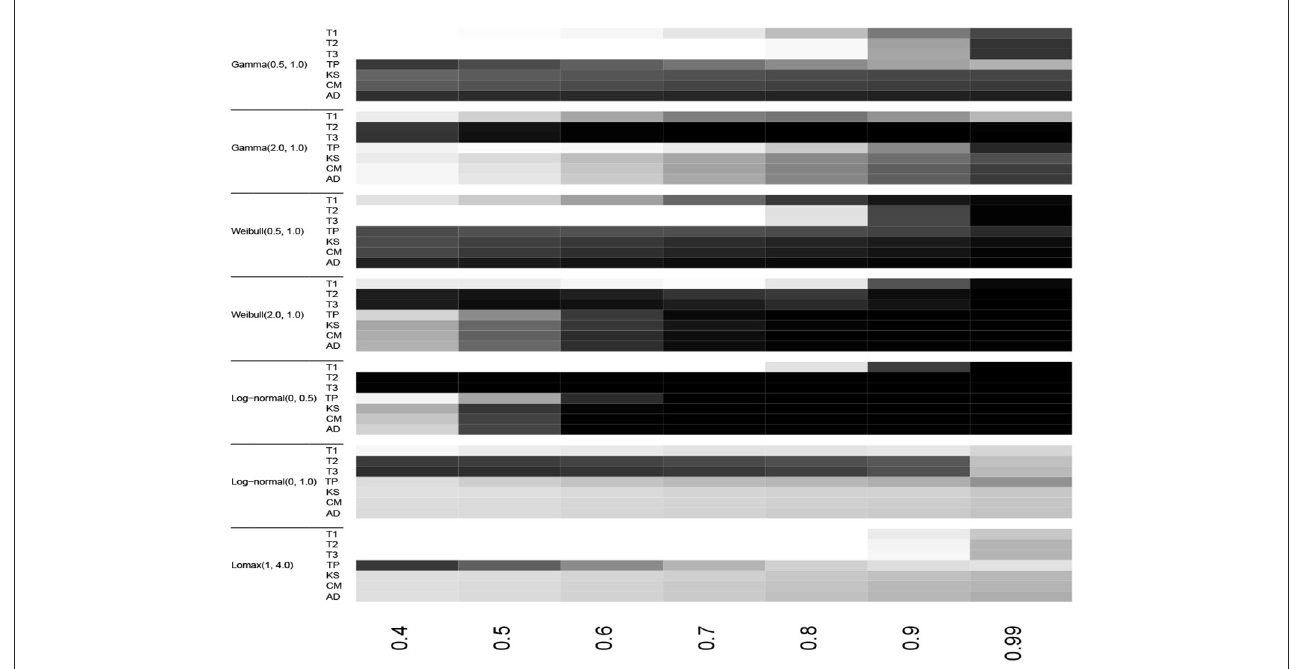
FIGURE6 Heatmap of the empirical powers listed in Table 5 for n